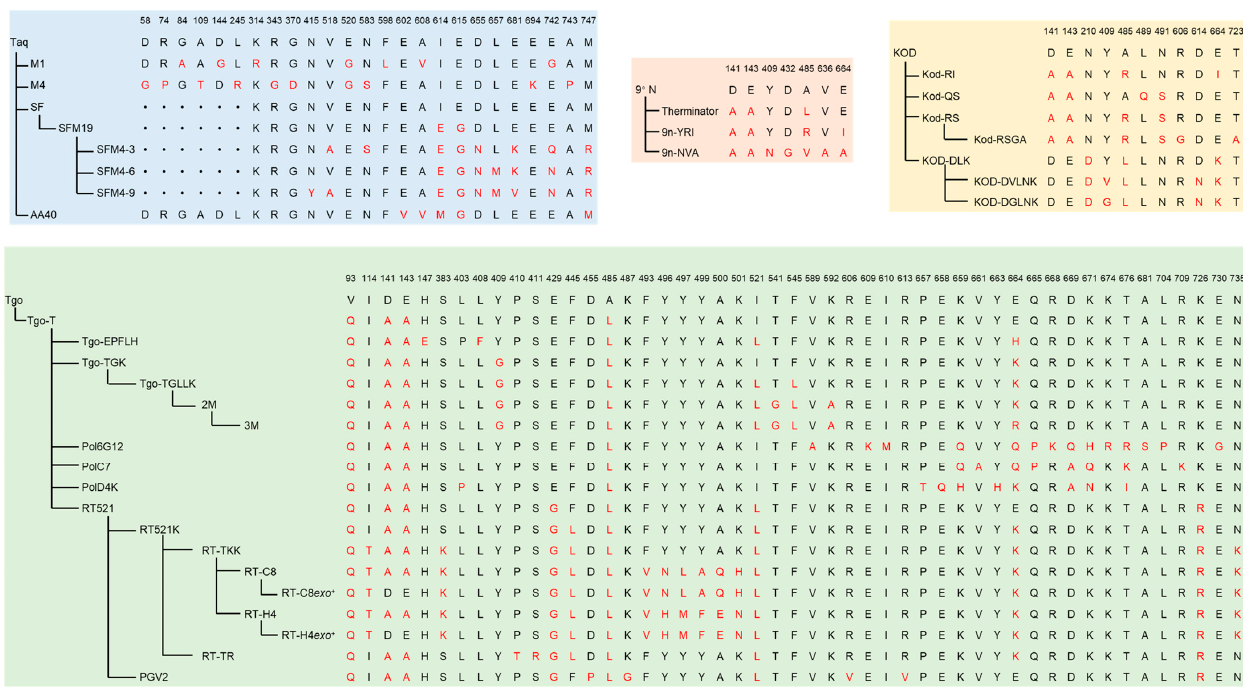
Figure 4. Summary of the relationships and mutations of some representative engineered XNAPs. The mutated amino acids in the engineered XNAPs are indicated in red.